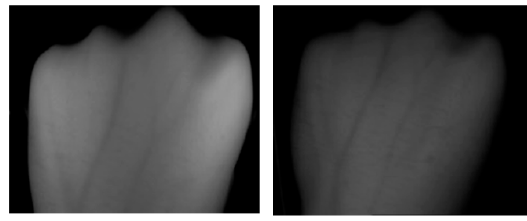
Figure 15. Di ff erence in Figure 15. Difference in brightness.